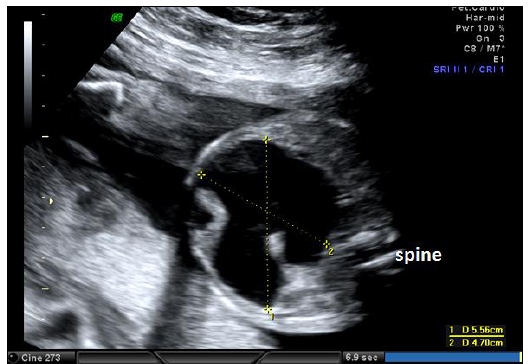
Figure 1: The pelvic cystic structure (55 x 47 mm) with irregular borders.